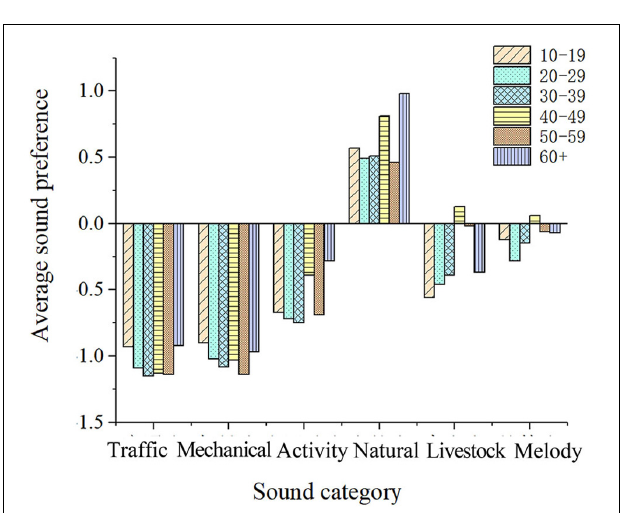
FIGURE 6 | Average soundscape preference of varying age